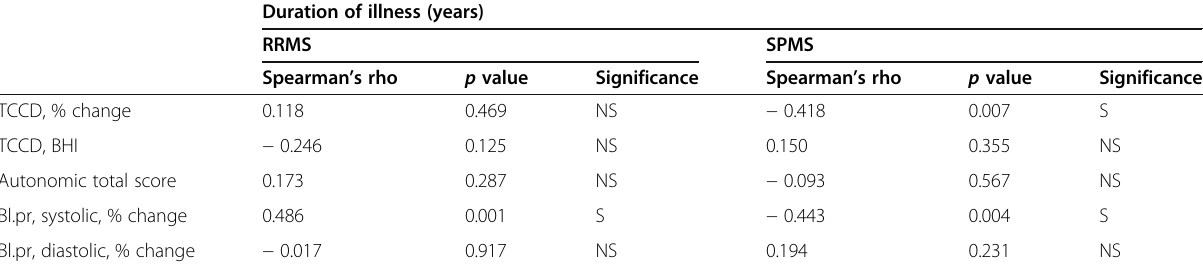
Table 3 Correlation between duration of illness and TCCD, autonomic functions, and blood pressure in both case groups Duration of illness